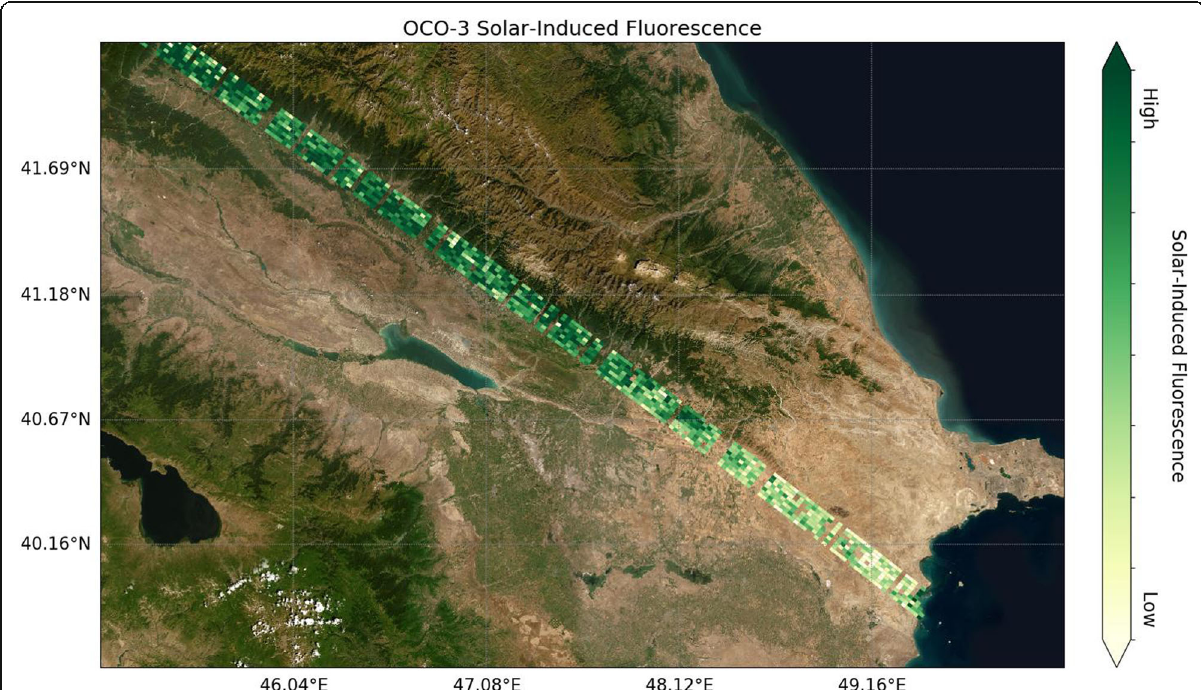
Fig. 23 The first preliminary SIF data from OCO-3, showing a strip from the edge of the Caspian Sea inland into Azerbaijan, superimposed over a true color image. Vegetation near the Caspian Sea is steppe and grasslands but it becomes forested as it moves into the mixed broadleaf deciduous forests of the southeastern Greater Caucasus Mountains, located north of the Mingachevir Reservoir (near the figure center). Credit: